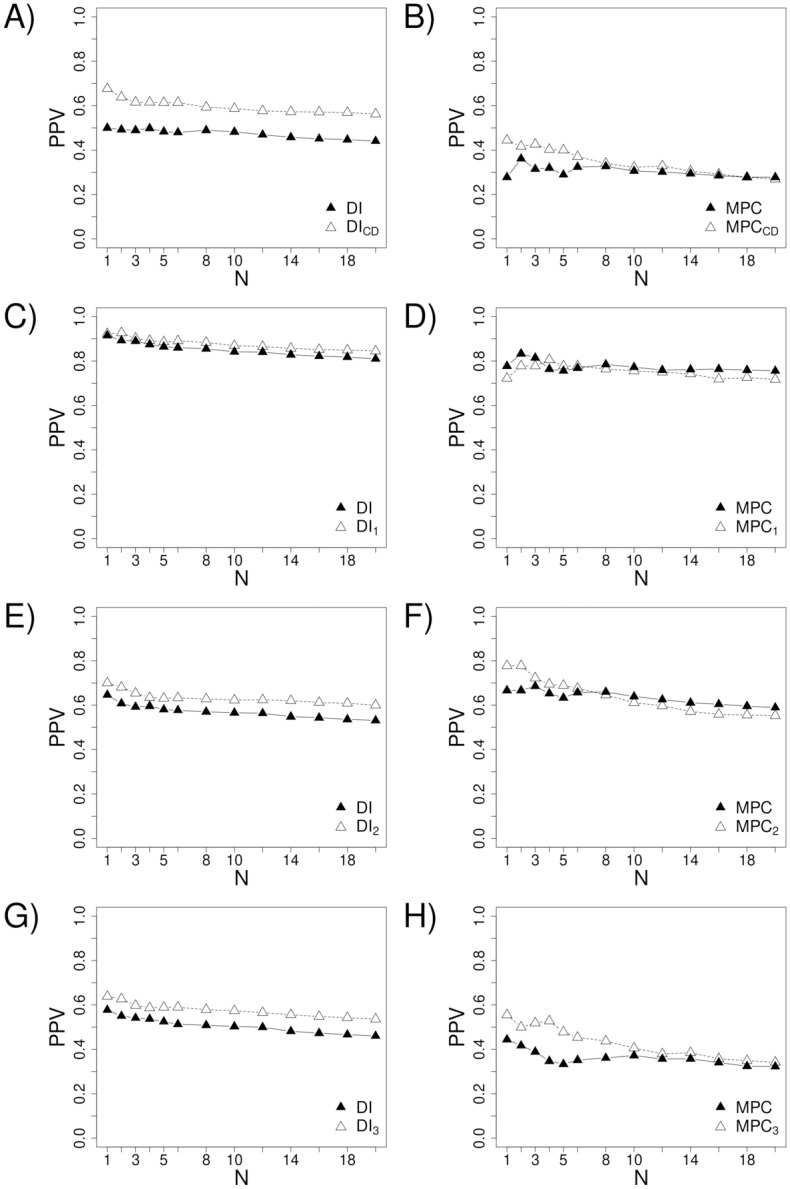
The effects of incorporating a contact potential into contact prediction.In plots A, C, E, and G, DI refers to predictions made using direct information alone. In plots B, D, F, and H, MPC refers to MetaPSICOV’s predictions alone. DICD and MPCCD respectively refer to DI and MPC’s predictions augmented by contact degree (see Eq (3)). Similarly, for n ∈ {1, 2, 3}, DIn and MPCn respectively refer to DI and MPC’s predictions augmented by contact definition n.